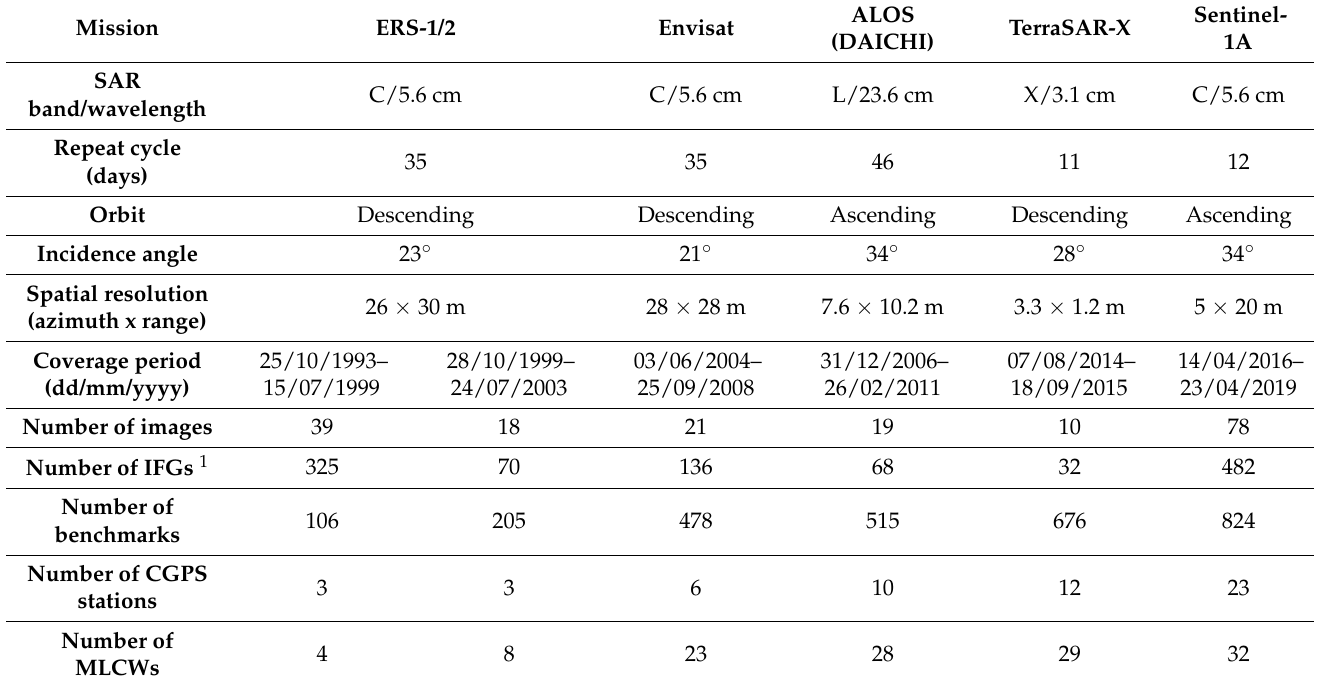
Table 1. SAR datasets with related information and numbers of ground stations for assessing SAR-derived deformations for each